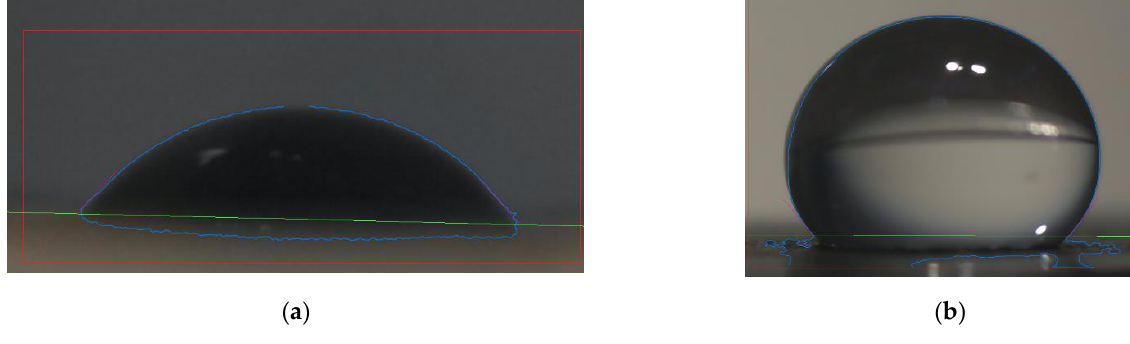
Figure 9. Contact angle of ( a ) CNT-buckypaper and ( b ) commercial CP. The HPRv values obtained in MEC1 (29.3 mL/L/d) are similar to those reported in